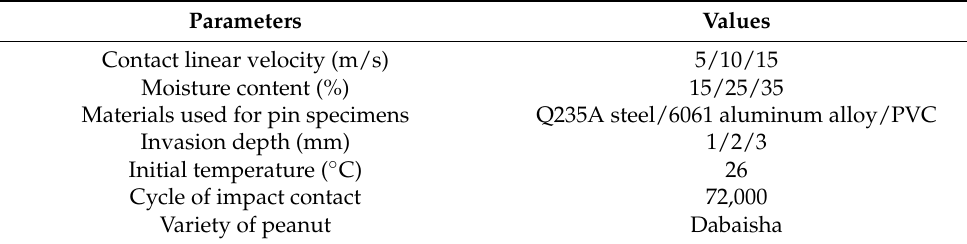
Table 1. Experimental